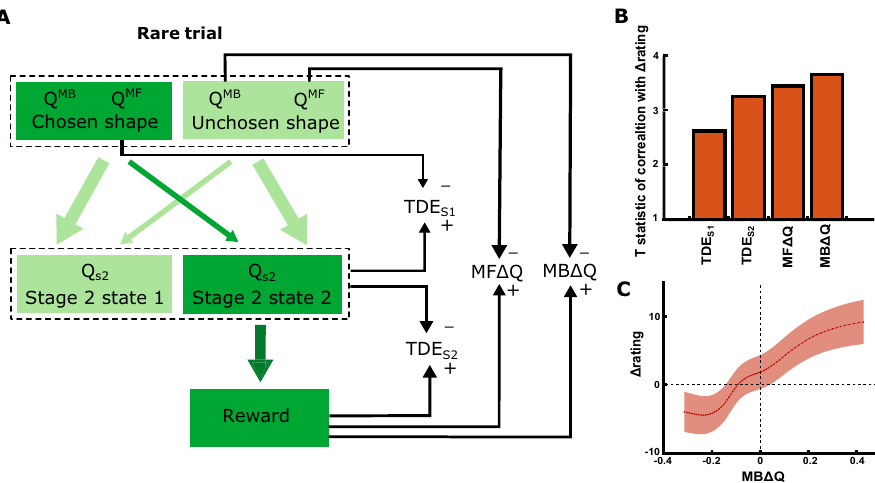
Figure 3. Contribution of reward prediction error estimates to rating changes. ( A ) Four RPEs were examined. On a rare-transition trial, state-values and action-values are updated at the time stage 2 is revealed, and at reward. This leads to a temporal difference error at stage 1 (TDE S1 ) and at stage 2 (TDE S2 ). Retrospectively, the values of the unchosen colour could also be updated, since in future, it is most likely to lead to the current stage 2 shapes. This update in its Q-value reflects the reward either relative to its cached model-free value (MFΔQ), or relative to its expected model-based value (MBΔQ). ( B ) Regression t-statistic between change in ratings and each of the four RPEs. ( C ) Change in participants’ ratings, binned by quantiles of MBΔQ. A sliding window of 20 percentiles was used within participants. Line shows mean of bin, with shaded area reflecting SEM across